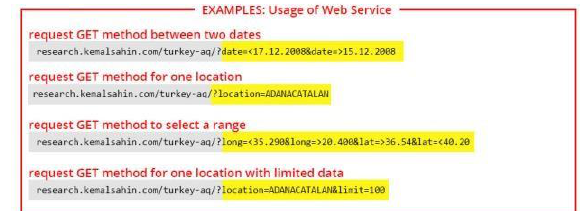
Figure 2. Sample Web Service Requests